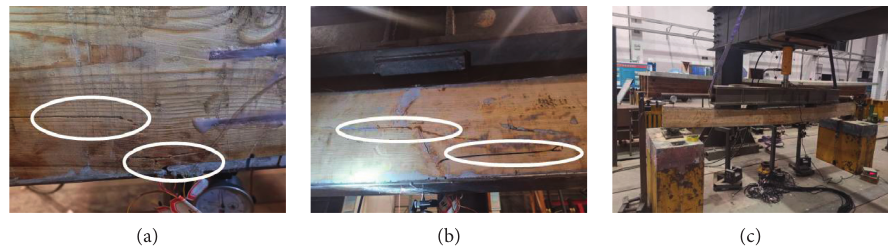
Figure 7: Failure mode of L2 specimen. (a) Slight cracking in the middle. (b) Cracks in the web in tension area. (c) Bending